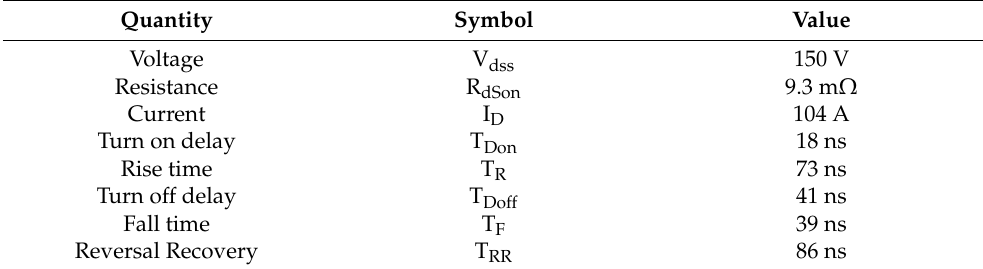
Table 3. CHBMI MOSFET IRFB4115PBF technical data.